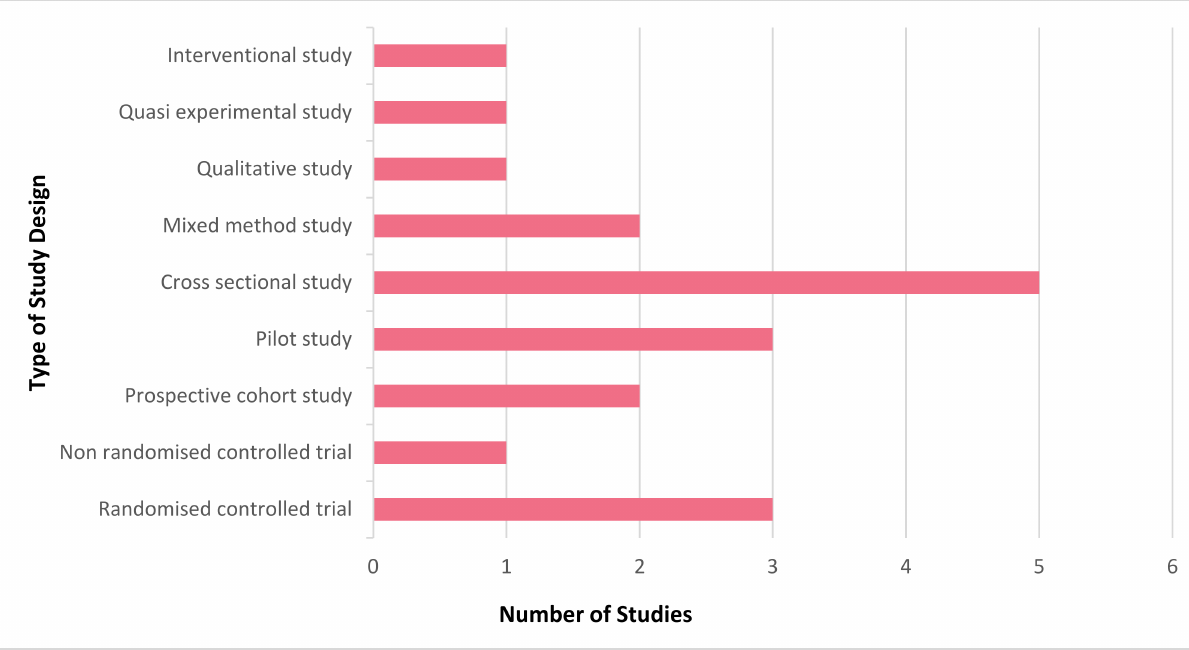
Figure 4. Different types of study designs of the articles